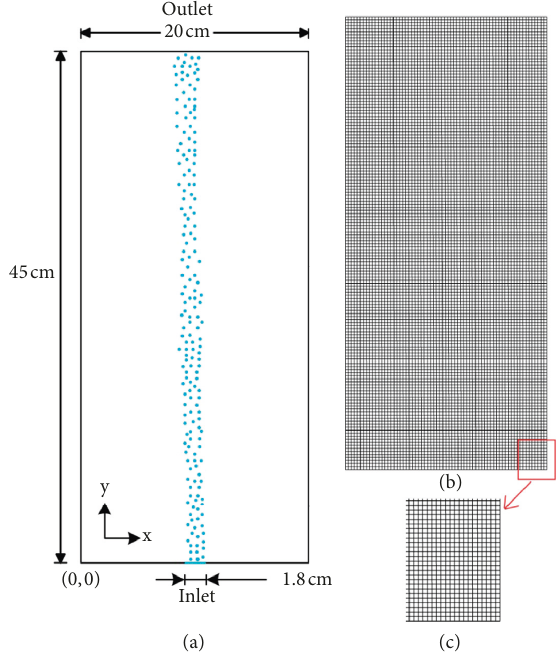
Figure 1: The physical model configuration and